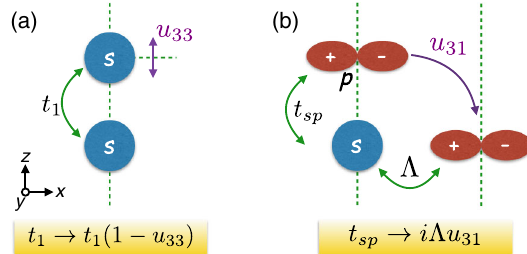
FIG. 2. The effect of strain on the hopping amplitudes in the tight-binding model. (a) Unidirectional strain along the z axis simply changes the distance between the neighboring orbitals leading to the modification of the hopping amplitude t 1 that is linear in u 33 to leading order in small displacement. (b) Torsional strain changes the relative orientation of the orbitals and brings about hopping amplitudes that are disallowed by symmetry in the unstrained crystal, such as t . The corresponding mathematical sp expression encodes the expectation that t would become equal sp to Λ if the p orbital were displaced all the way to the horizontal position. In the real material, one of course expects Eq. (2.8) to be valid only for displacements that are small compared to the lattice parameter a